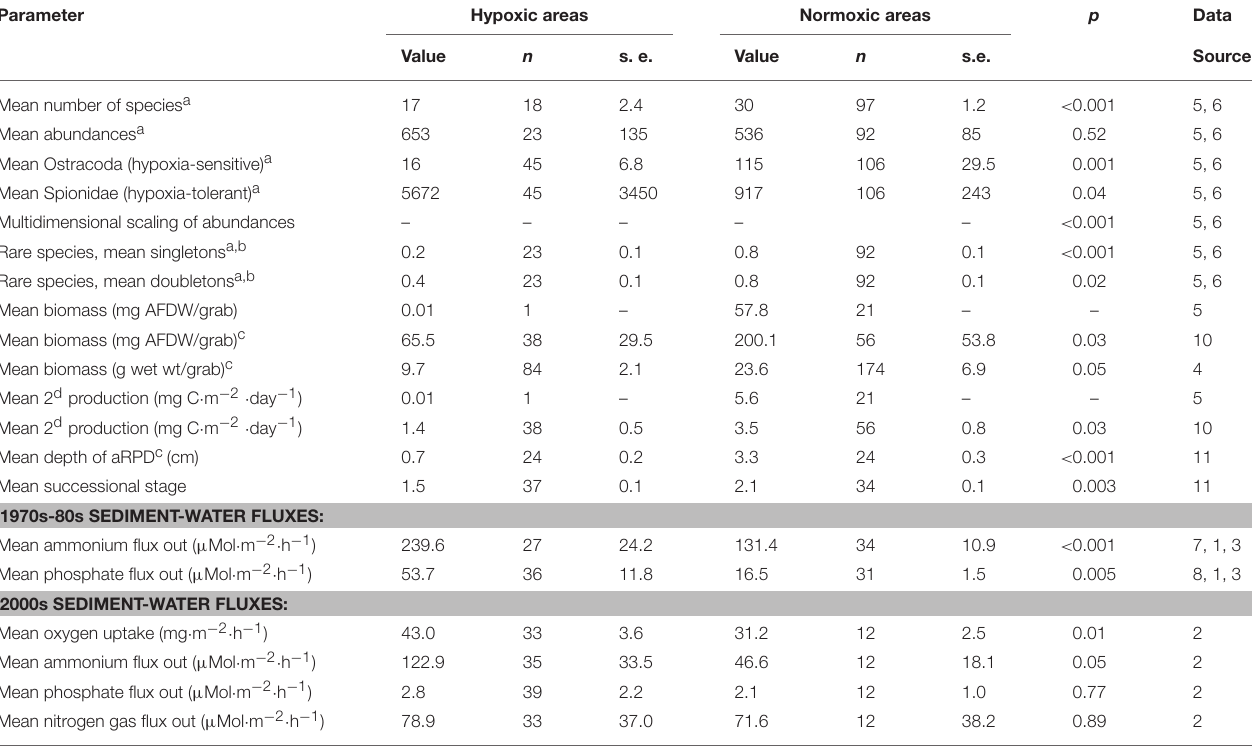
TABLE 2 | Benthic structural and functional parameters in hypoxic areas vs. normoxic areas of Narragansett Bay. Parameter Hypoxic areas Normoxic areas p Data Value s.e.